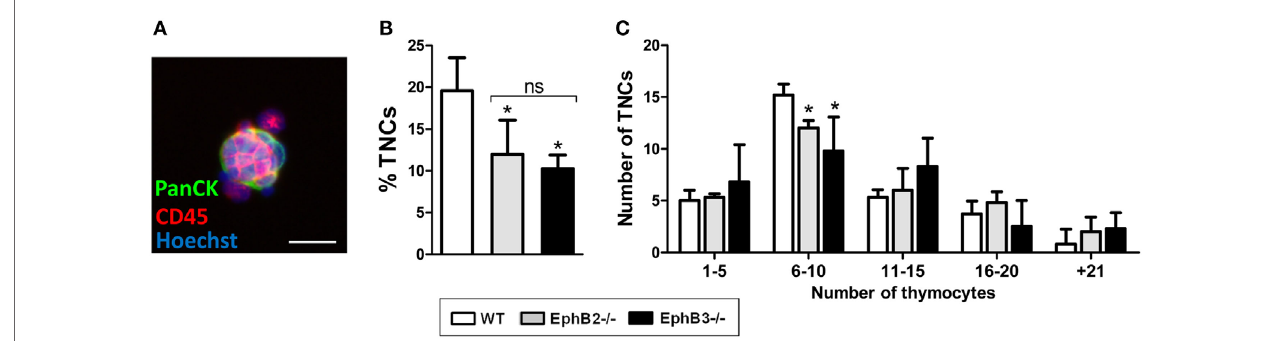
FigUre 2 | Analysis of thymic nurse complexes (TNCs) in adult WT and EphB-deficient thymi. (A) Representative thymic nurse complex formed by thymic epithelial cells, stained with an anti-PanCytokeratin antibody (PanCK, Green) and thymocytes identified by using an anti-CD45 antibody (Red). Nuclei are stained with Hoechst 33342 (Blue). Scale: 20 µm. (B) A significantly lower percentage of isolated TNC in EphB2 − / − and EphB3 − / − thymi than in WT ones. (c) According to the number of thymocytes included in the TNCs, six different groups could be established. The figure shows the TNC numbers of WT and EphB-deficient thymi after the analysis of 30 TNCs. In both WT and mutant thymi, the distribution is similar but the frequency of those containing 6–10 thymocytes, which represent the half of total TNC analyzed, is lower in mutant than in WT ones. The significance of the Student’s t -test probability is indicated as * p ≤ 0.05. ns: